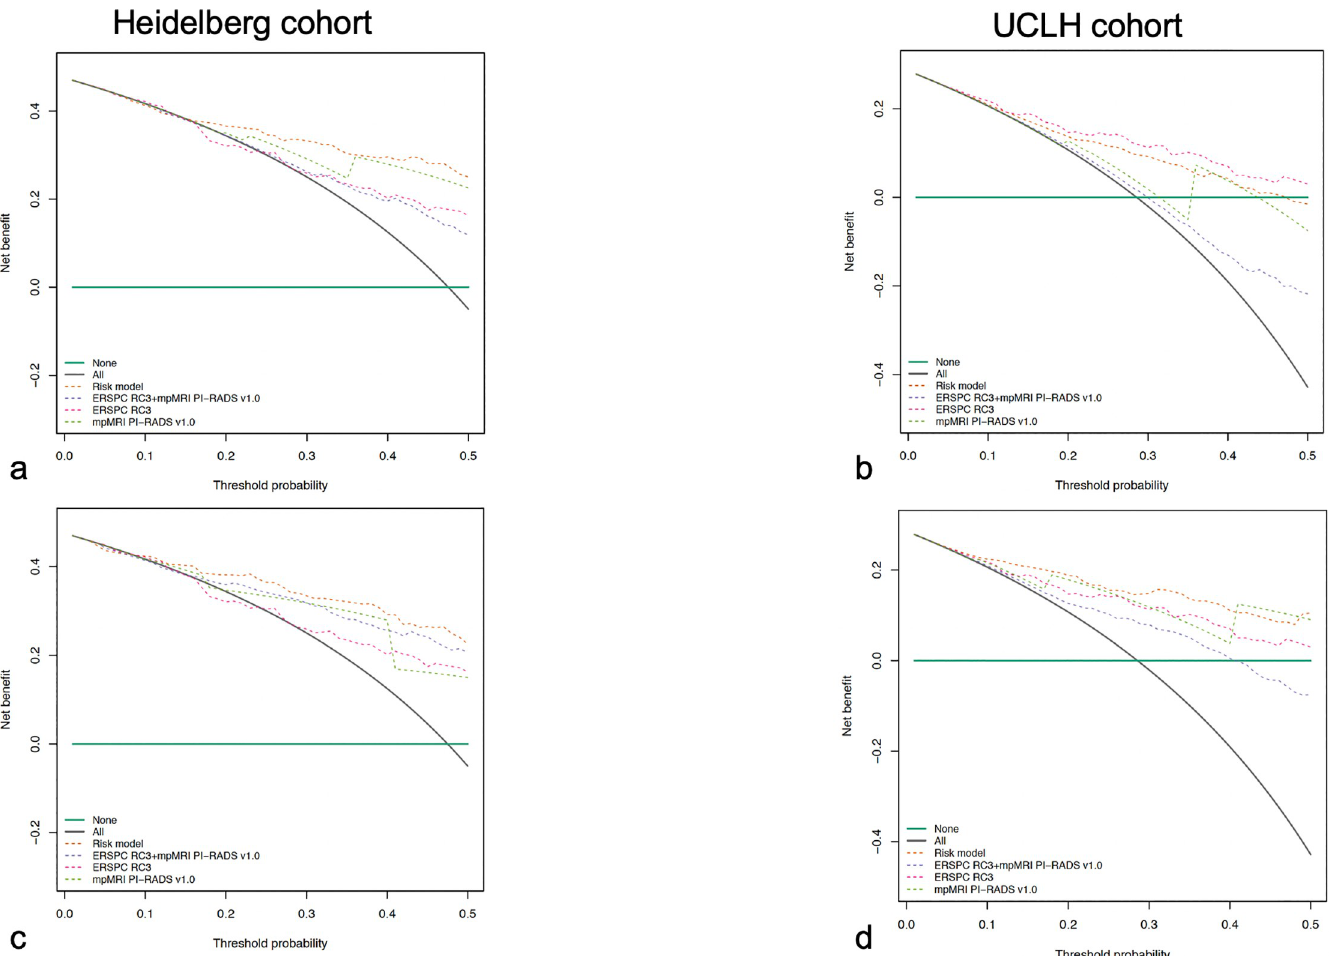
Fig 3. Net decision curve analyses demonstrating the benefit for predicting sPC on biopsy: a) for the unadjusted RM in the Heidelberg cohort, b) for the unadjusted model in the UCLH cohort, c) for the adjusted model in the Heidelberg cohort (according to the prevalence of the ERSPC 24.5%) and d) for the adjusted model in the UCLH cohort. The black line is the net benefit of providing all patients with MRI/TRUS-fusion biopsy and the horizontal green line is the net benefit of providing no patients with biopsy. The net benefit provided by each prediction tool is given (pink line for ERSPC-RC3, green line for mpMRI PI-RADSV1.0, purple for ERSPC RC3 +mpMRI PI-RADSv1.0 and orange line for the